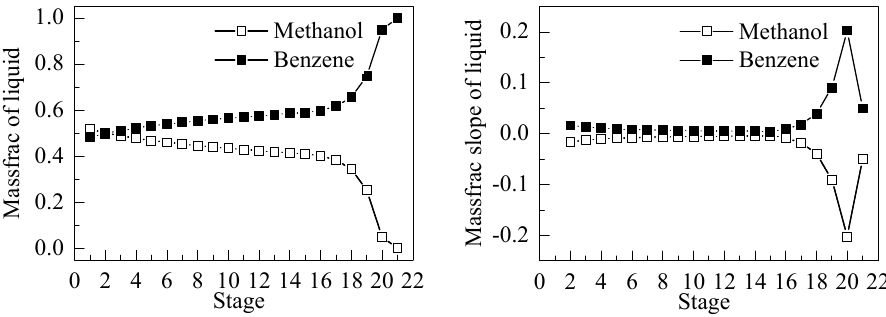
Figure 9. Composition distribution and its slope distribution of HPC.